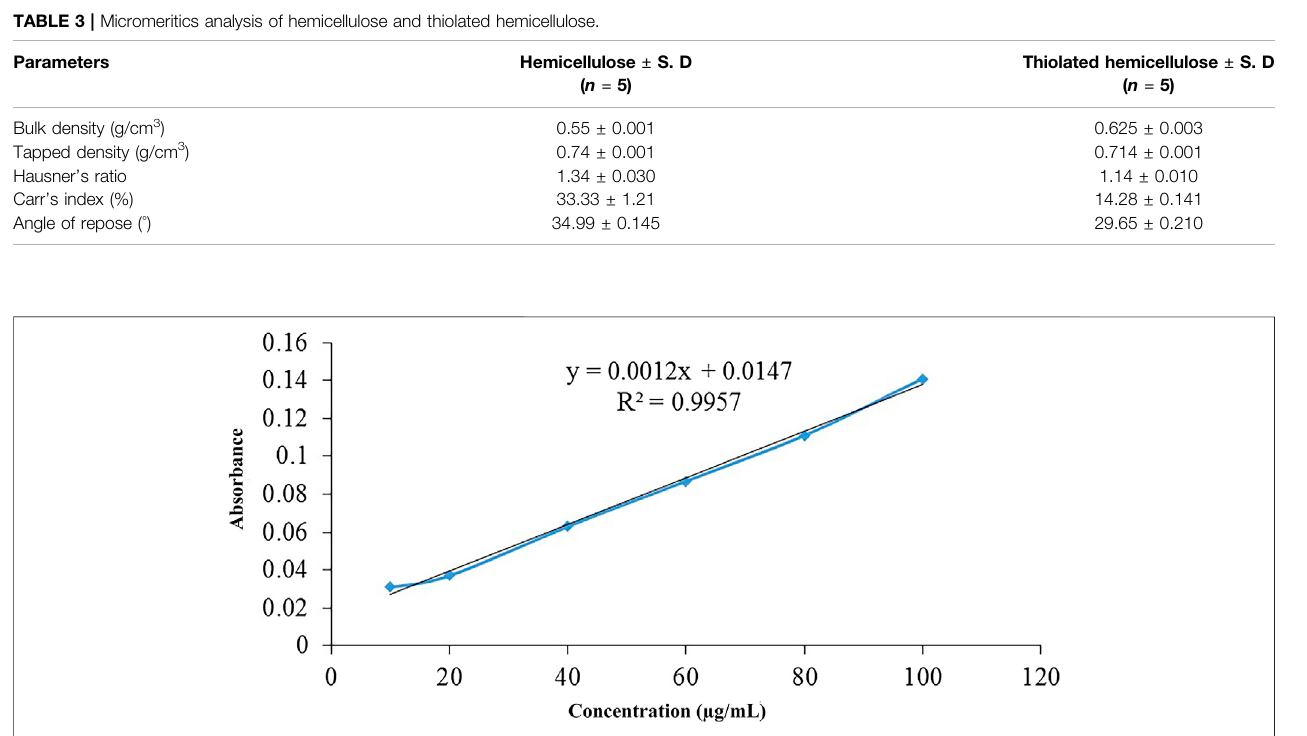
FIGURE 3 | The calibration curve of thiourea was obtained by using serial dilutions, ranging from 10 to 100 µg, and analyzing them by a spectrophotometer at 280 nm wavelength. R 2 was found to be 0.9957, which demonstrates a good linearity.